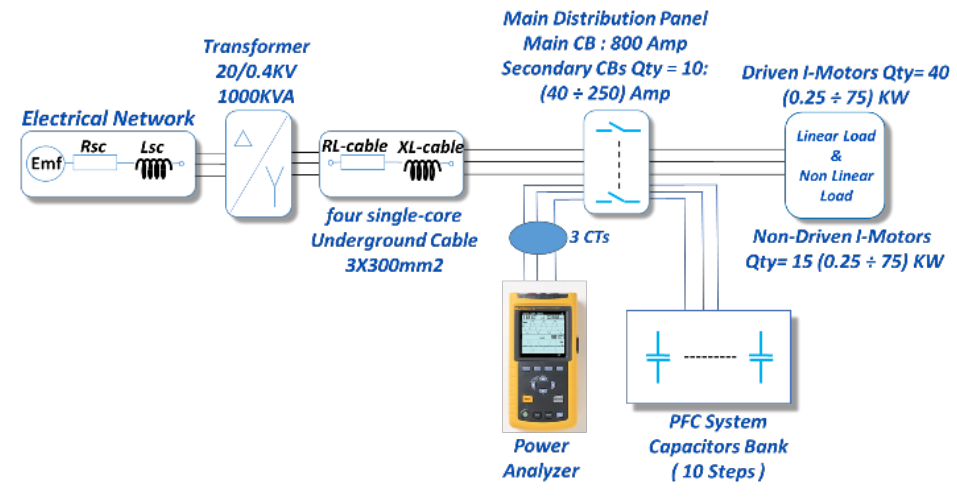
Figure 16. Electrical grid of the textile factory.